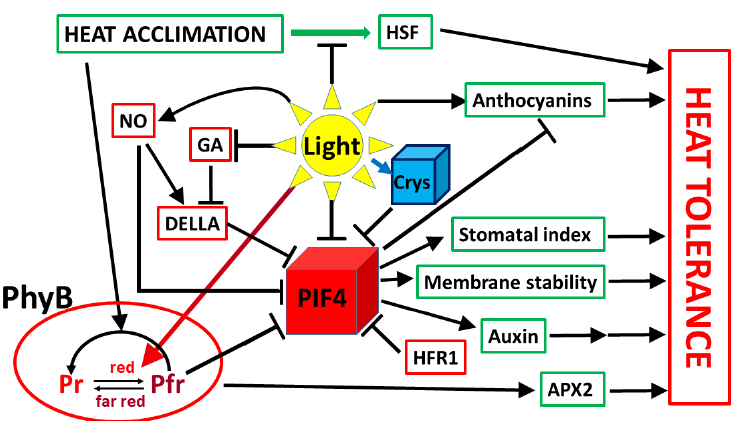
Figure 2. Possible main factors playing a role in light–high-temperature interactions in plants. PIF4 probably plays a central but not exclusive role in the light-mediated acclimation processes, including—among others—regulation of gas exchange, membrane stability, and hormonal regulation. The role of PhyB is controversial. In some processes, it enhances heat tolerance; in others, it reduces heat tolerance. GA: gibberellic acid. For more details, see text.